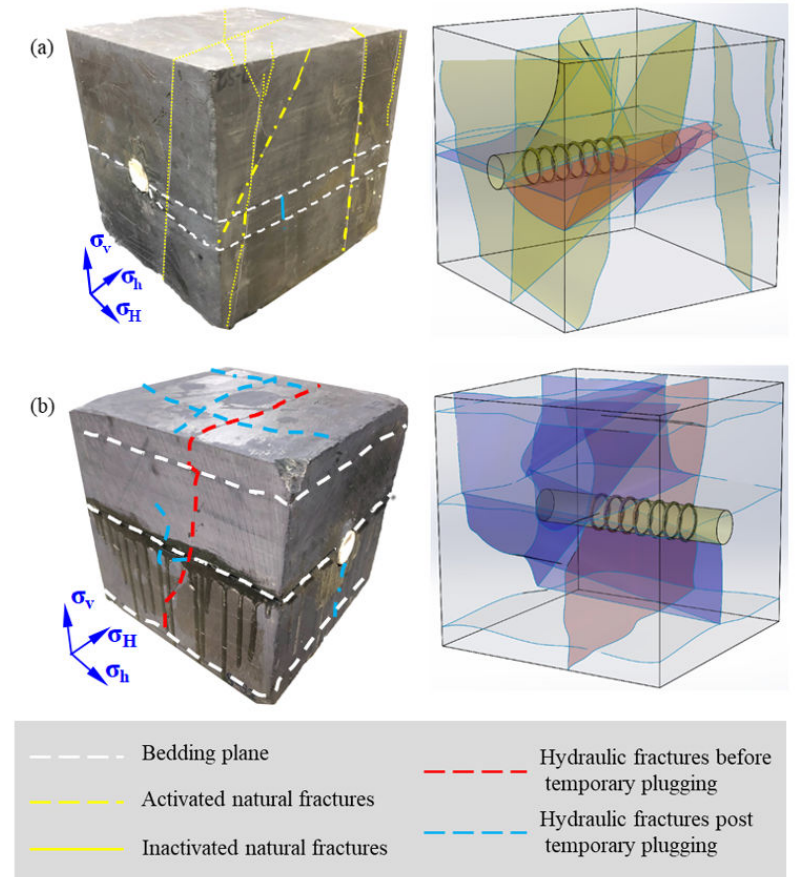
Figure 4. Fracture geometry and 3D reconstruction of temporary plugging fracturing under different temporary plugging agent concentrations: ( a ) Specimen 6#, ( b ) Specimen 7#, (left: apparent fracture geometry of rock sample, right: 3D reconstruction of fracture